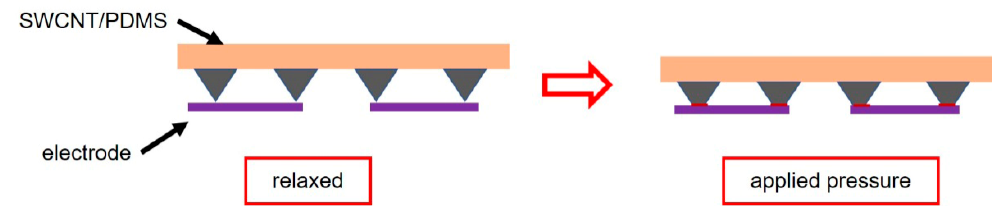
Figure 3. Schematic diagram of sensing mechanism.